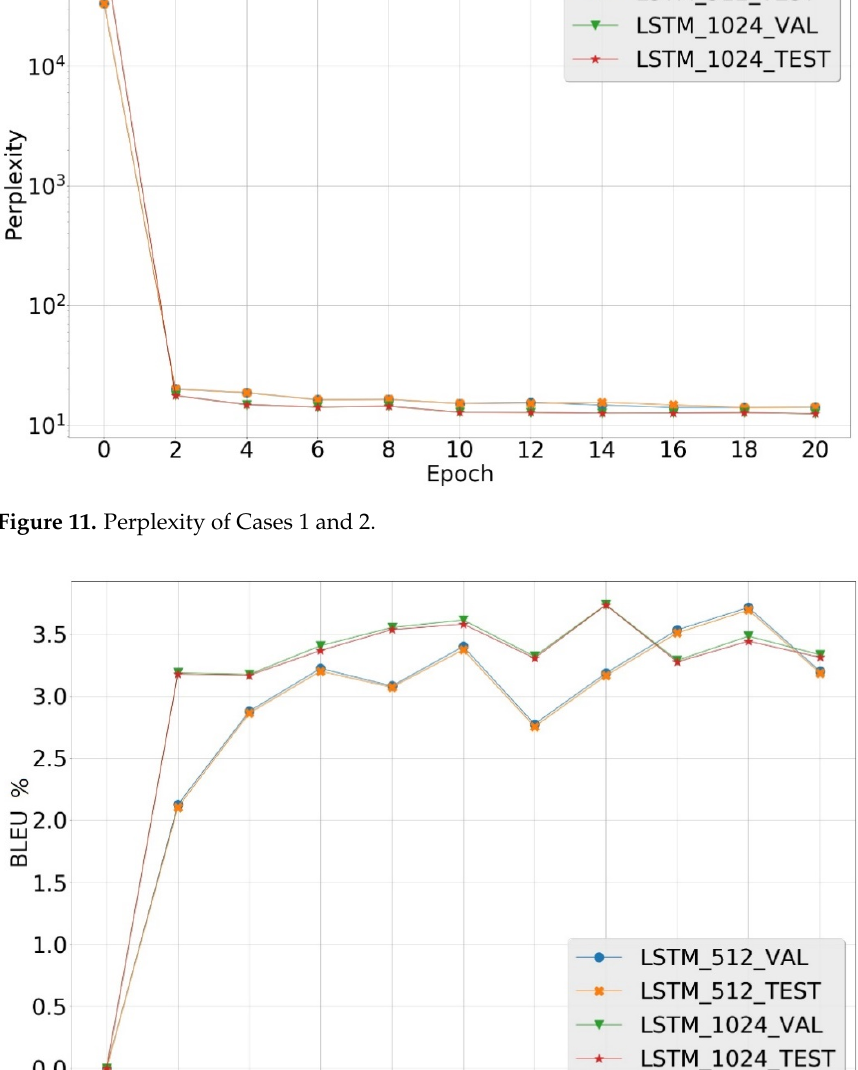
Table 4. Best performances of Cases 1 and 2.